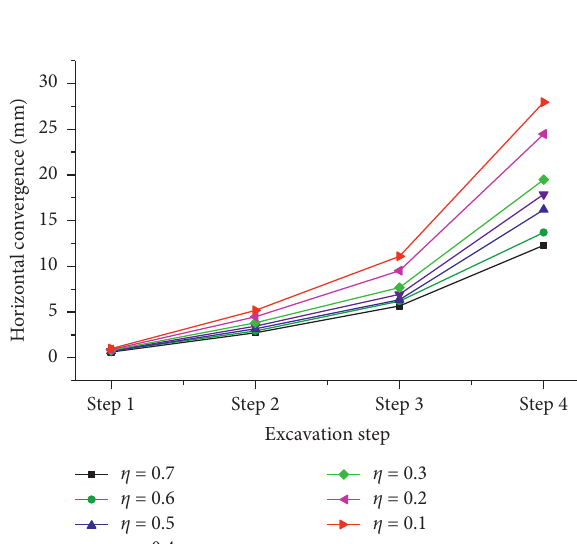
Figure 25: Final deformation state (100x magnification).